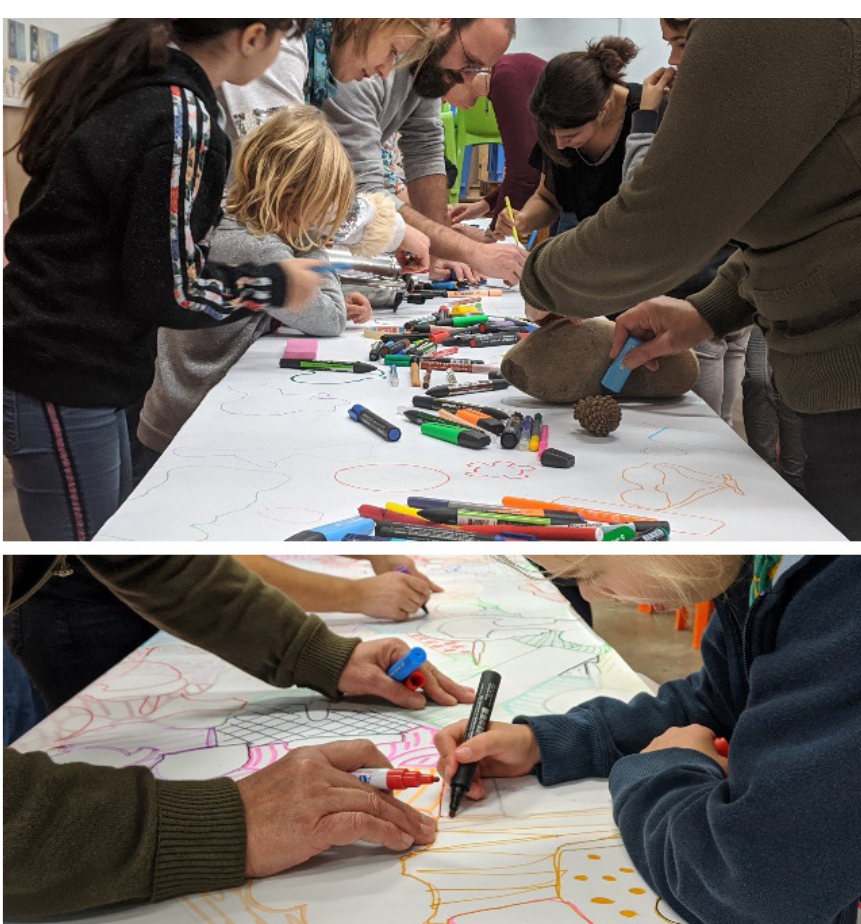
Figure 7. Peaceful alignment through co‐creation (picture above) and co‐regulation (picture below). Picture below shows a girl being supported by her grandmother in outlining a shape on chalk paper, from IM workshop 1. Both offer opportu‐ nities to experience and develop emotional attachment. Source: Ruth